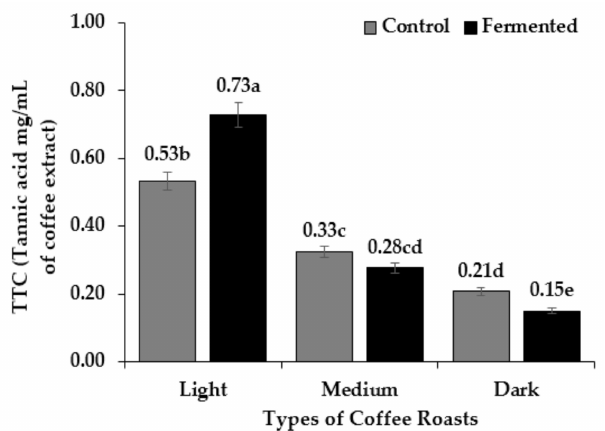
Figure 8. Total tannin contents (tannic acid mg / mL of co ff ee extract) of fermented co ff ee. Bars with di ff erent letters indicate a significant di ff erence ( p < 0.5) among treatments.